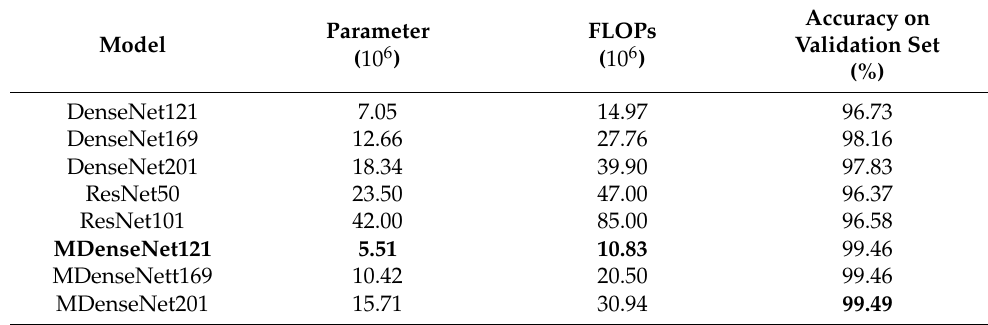
Figure 8. Training and testing method for Bamboo image classification. Table 2. Accuracy and floating-point operations per second (FLOPs) achieve by M-DenseNet in comparison with the other